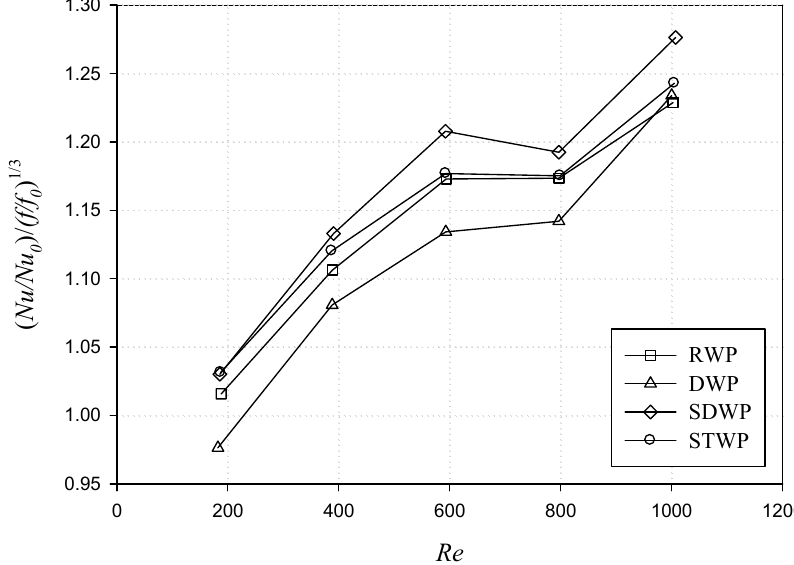
Figure 11. Variation of Nu / Nu 0 vs. Re of all heat sinks having VGs in this study.